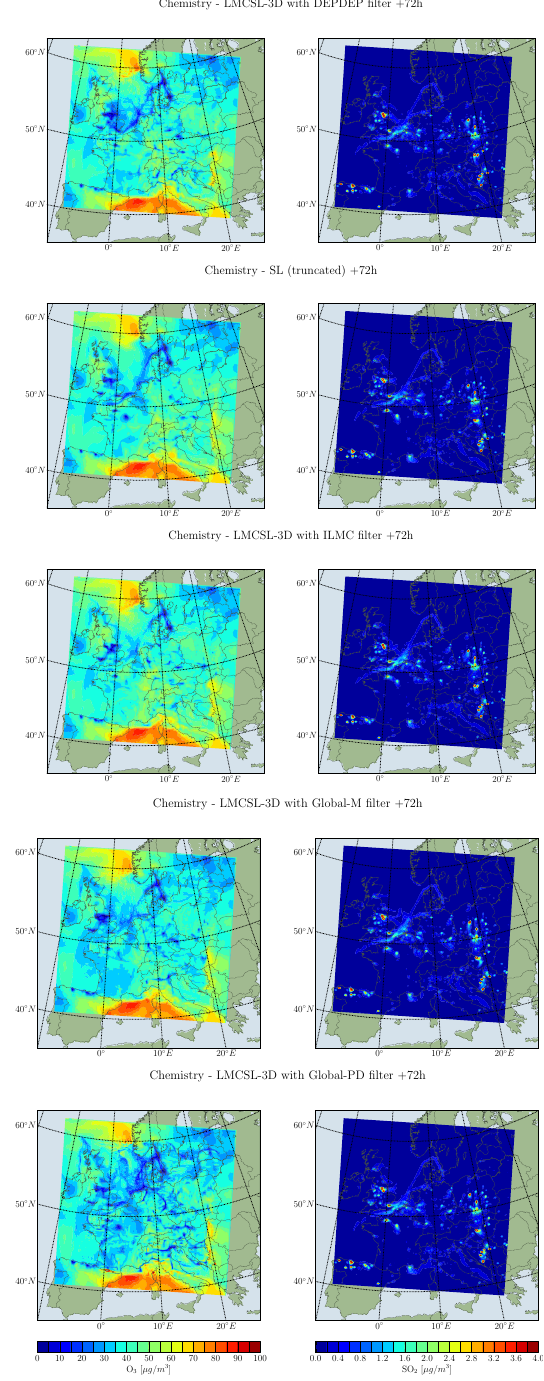
Fig. 8. Chemistry forecast. The panels on the left show the ozone field and the panels on the right show the sulphur dioxide field after 72h. The top row is the DEPDEP filtered solution, the second row is the truncated SL, the third row is the ILMC filtered solution, the fourth row is the globally shape preserving, and the bottom row is the globally positive definite solution. The simulation is from the 1st of July 2009 00:00 UTC to the 4th of July 2009 00:00 UTC.